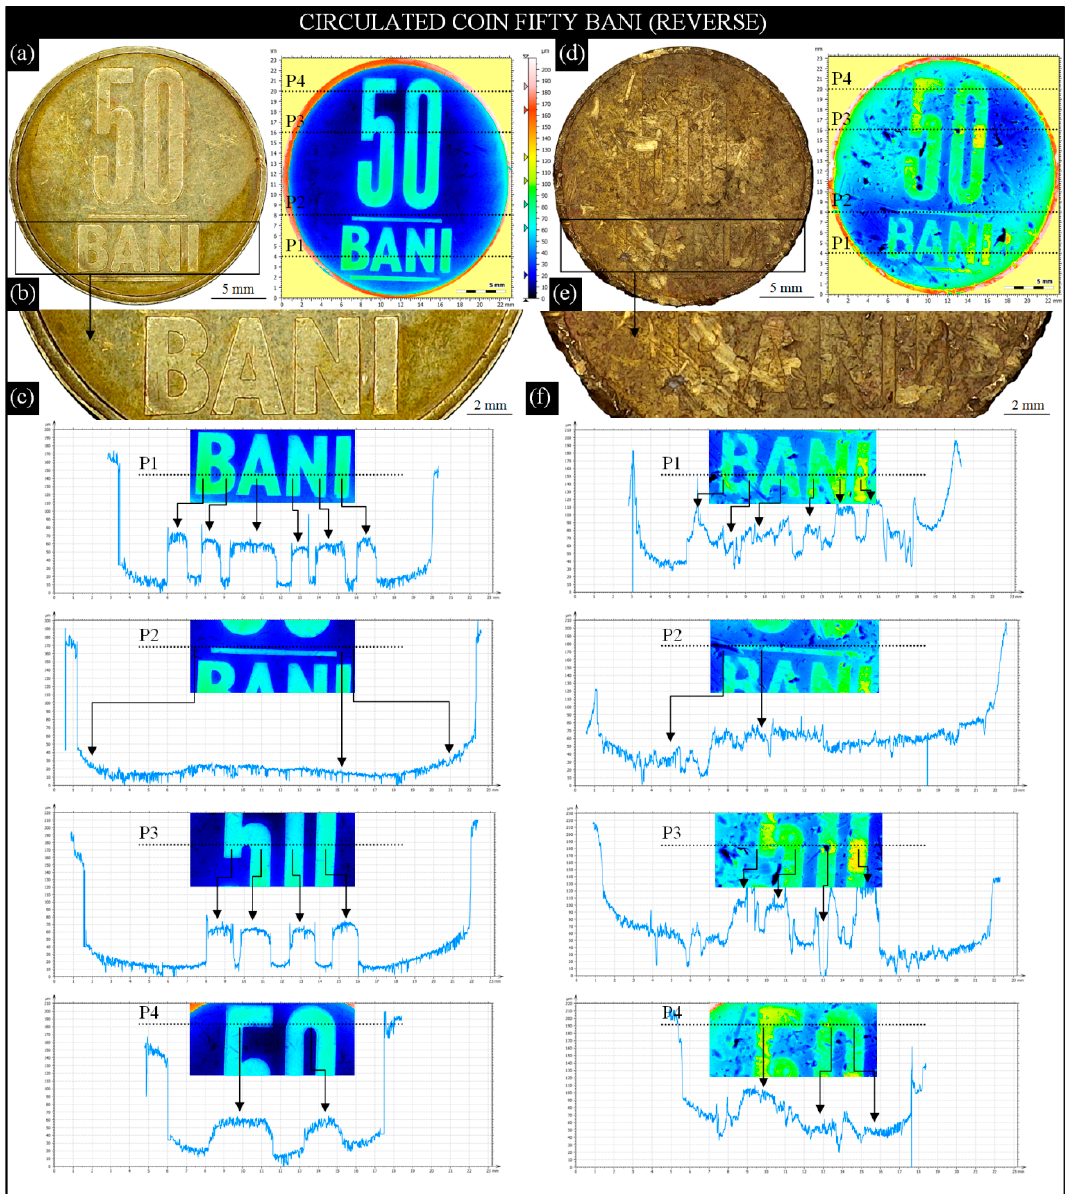
Figure 6. Selected results of observation and analysis of the surface condition of modern Romanian circu- lated 50 bani coins obtained by the digital microscope Omni Core (Ash Technologies Ltd., Kildare, Irela- nd) and 3D optical profilometer S neox (Sensofar Metrology, Terrassa, Spain): ( a – d ) general view of the coins (left: in condition between average and extensive wear (Phase II/III); right: in condition representing critical wear (Phase IV)) with a corresponding 2D height map (indexed colors); ( b – e ) AOIs (22.70 × 4.91 mm) extracted from Figure 6a–d presenting enlarged lettering B A N I for various conditions of surface wear; ( c – f ) surface profiles (P1–4 mm, P2–8, P3–16, and P4–20 mm) extracted from each of the coins.